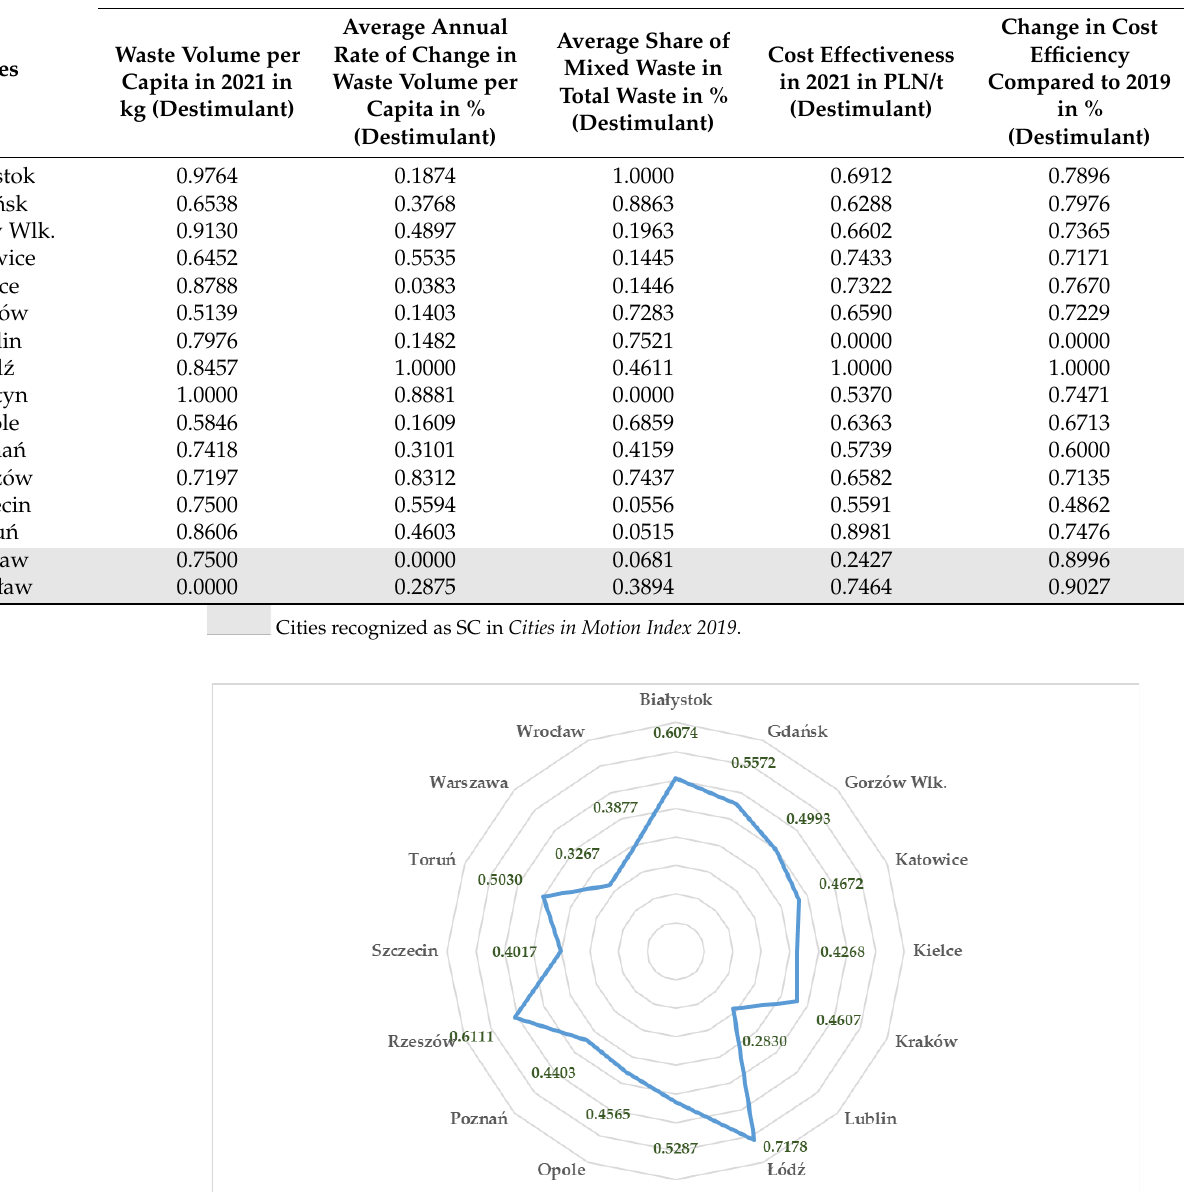
Table 2. Volume and average rate of change of municipal waste generated in the studied cities from 2019 to 2021 [in kg/inhabitant].